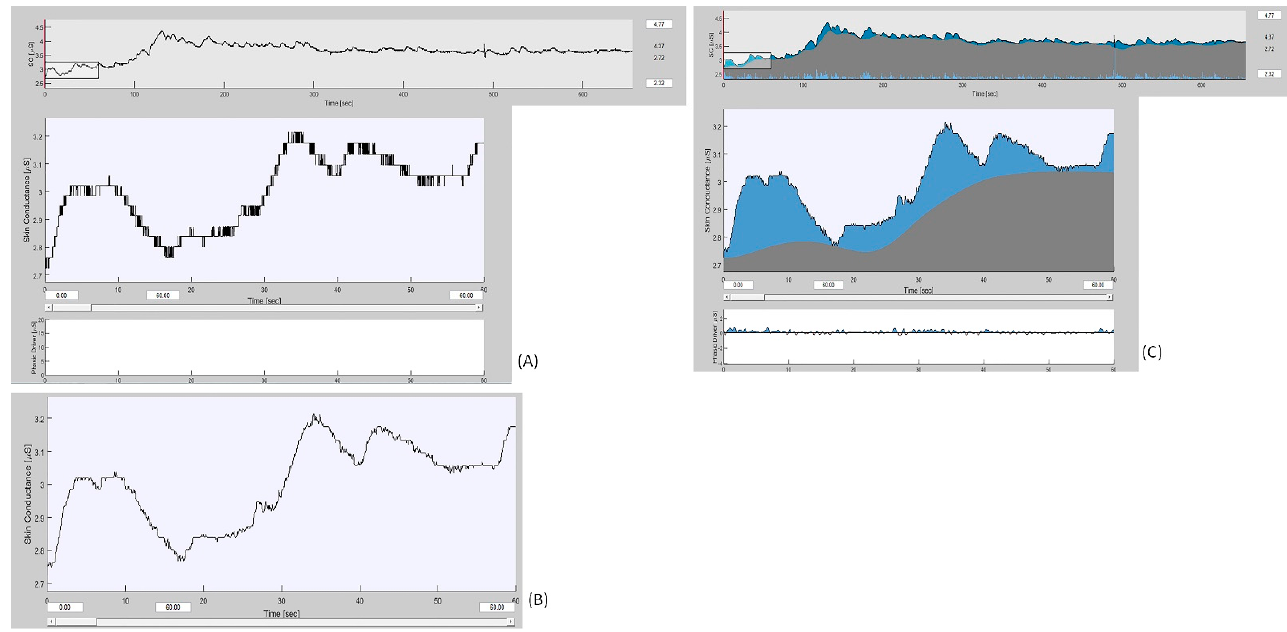
Figure 3. Galvanic skin response (GSR) signal processing: ( A ) the Ledalab interface displaying the raw signal (upper plot) and a 60-s portion of it (medium plot); ( B ) the same 60-s portion after the application of the first order Butterworth low-pass filter at 5 Hz; ( C ) the signal filtered (upper plot), the 60-s portion (medium plot) and the phasic component extraction after applying a continuous decomposition analysis (lower plot).